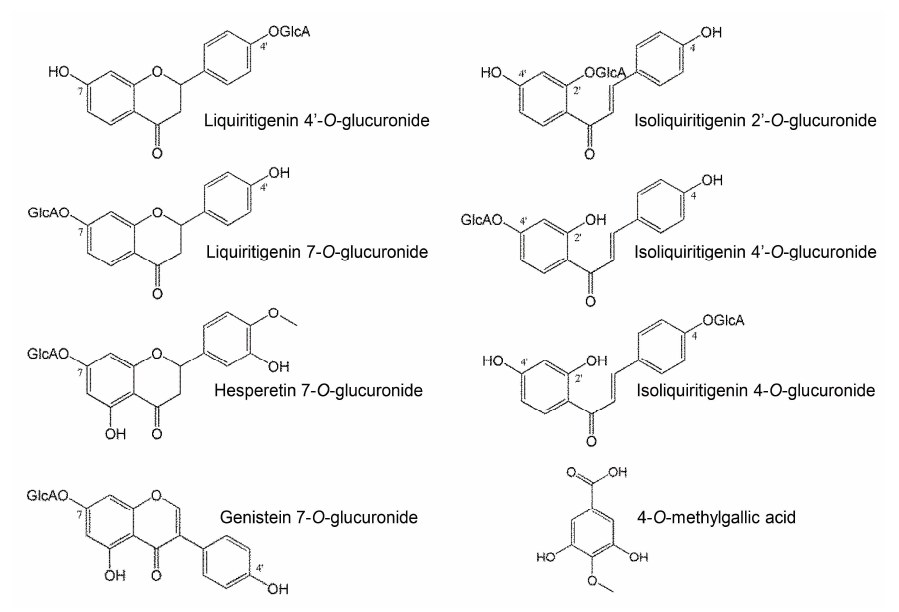
Figure 4. Concentration dependency of flavonoid glucuronides and comparison with aglycones. Glucuronides and aglycones of flavonoid were assayed at serially-diluted concentrations to assess on hydrogen peroxide-dependent oxidation. Test samples were incubated with hydrogen peroxide for 5 min, followed by mixing with a probe of oxidant activity. After 15 min incubation, the hydrogen peroxide-dependent fluorescent intensity was measured. Data are shown as mean ± S.E. of triplicates.